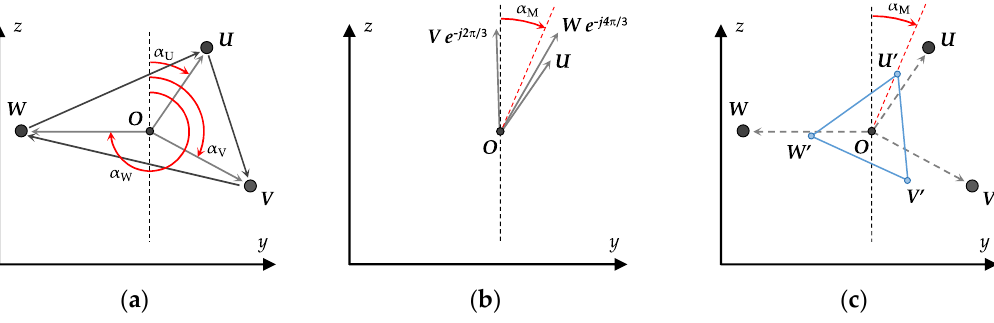
Figure 4. Graphical representation of the proposed procedure for evaluating the directions of forces applied to the rod insulators composing the compactors. ( a ) Wires configuration; ( b ) Evaluation of the average angle α M ; ( c ) Identification of updated directions of forces exerted by rod insulator composing the compactor (blue triangle).